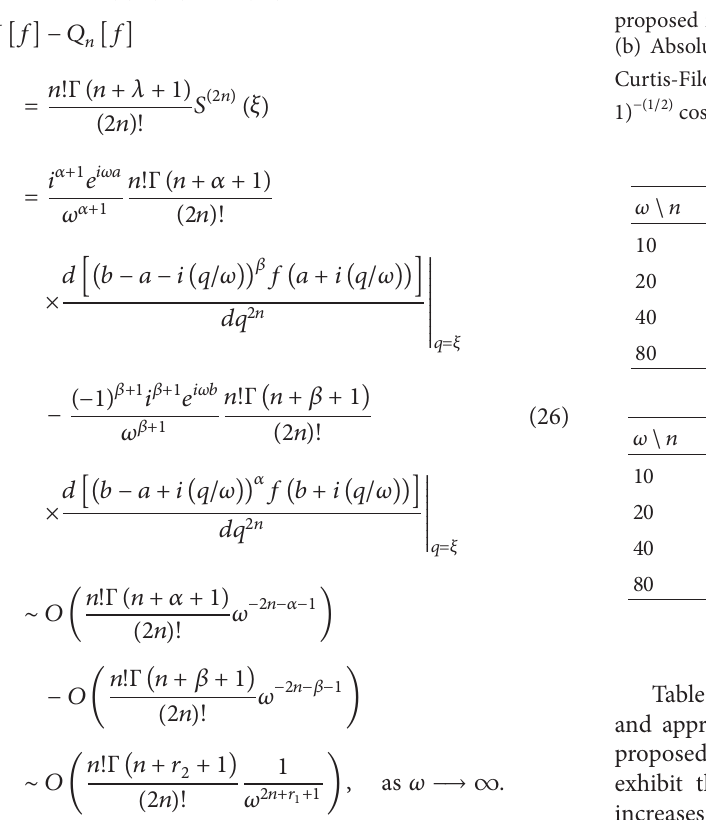
Table 1: (a) Absolute errors in 𝑛 -point approximations by